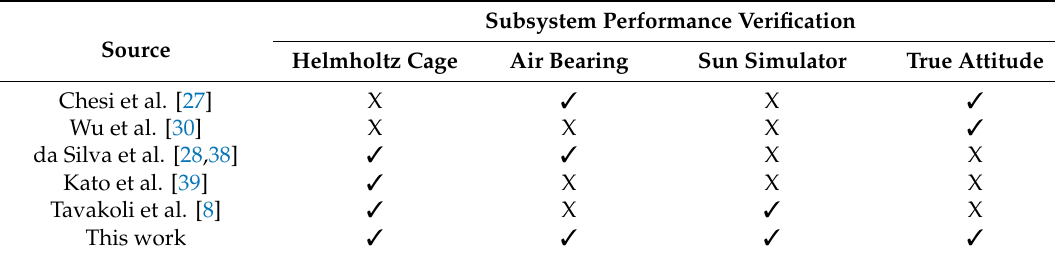
Figure 1. The dynamic hardware-in-the-loop facility for nanosatellites ADCS verification. Table 1. Survey on subsystems verification of air-bearing based ADCS testing